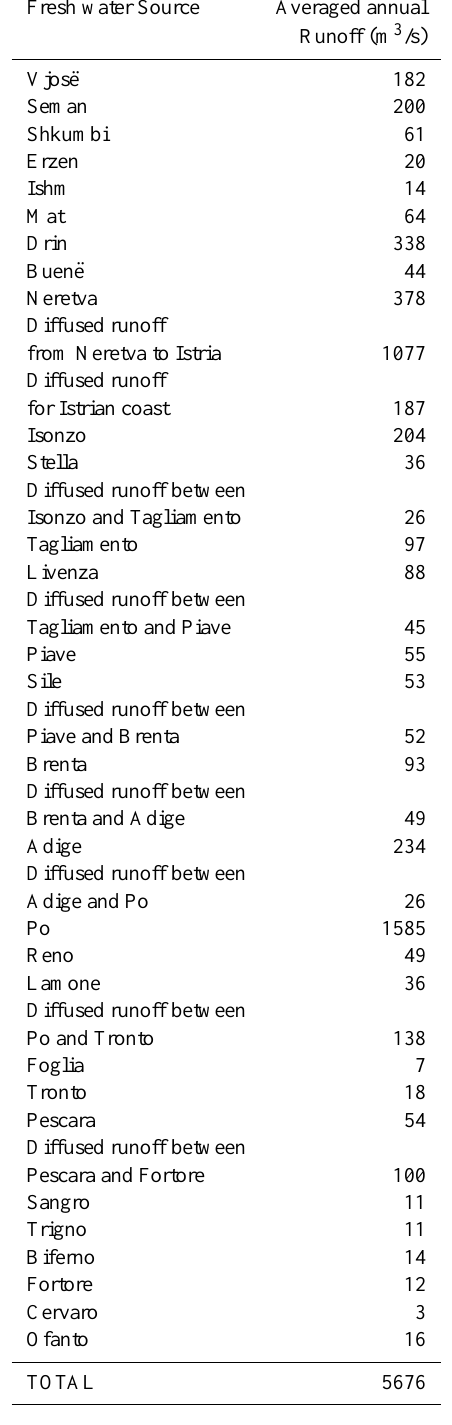
Table 1. Annually averaged runoff into the Adriatic Basin (From Raicich,